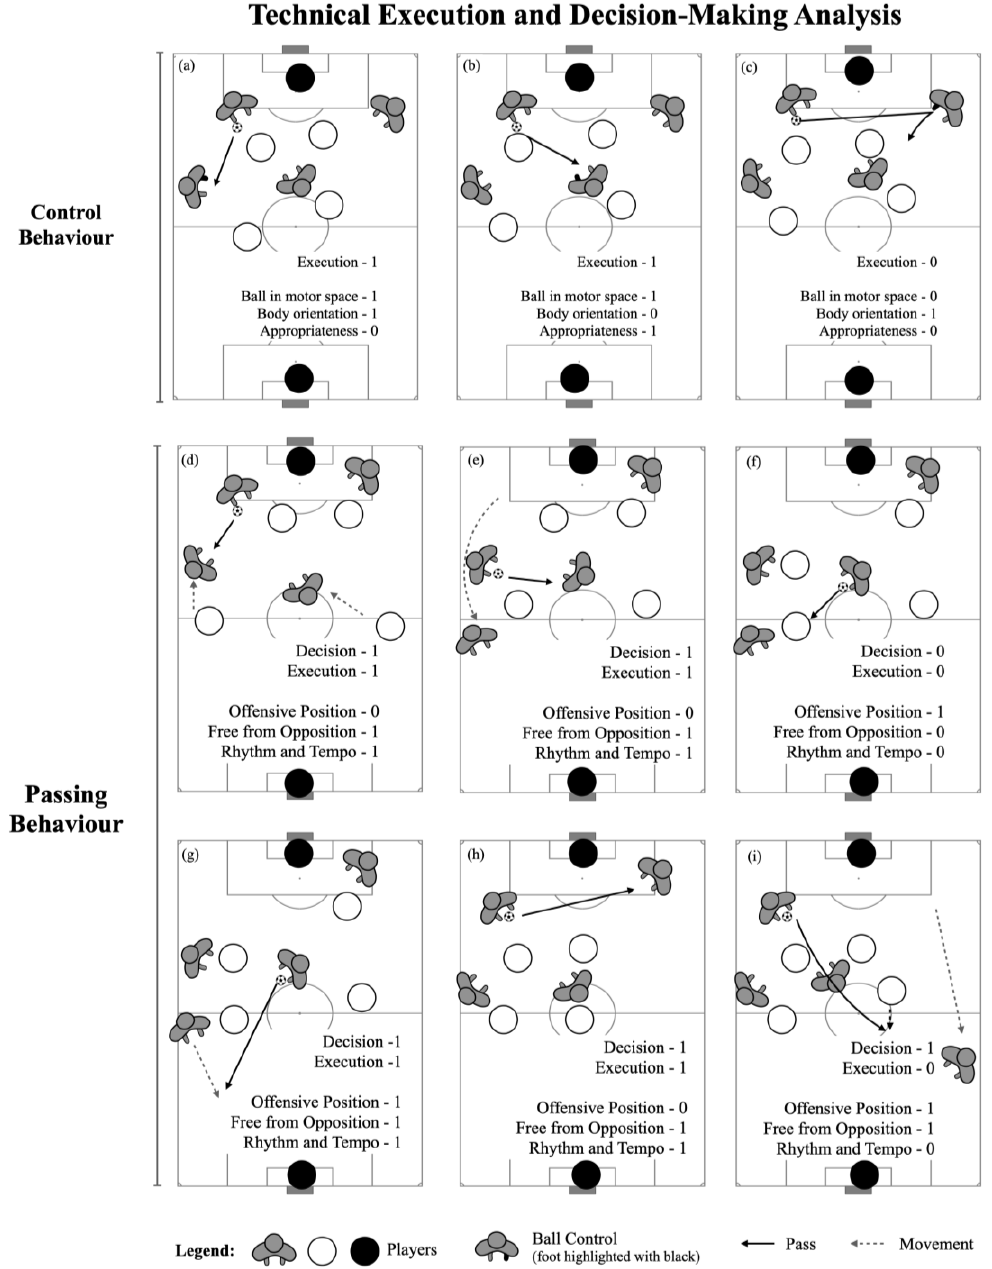
Figure 2. Representation of technical criteria of ball control and passing patterns. ( a – c ) analyses players’ ball control according to GPET instrument and the additional technical criteria to highlight how each criteria should be coded according to the specific context. ( d – i ) have also GPET and technical criteria analysis however, regarding the players’ passing behaviour. Note: dashed line represents players’ movement, while continuous line refers to ball trajectory.